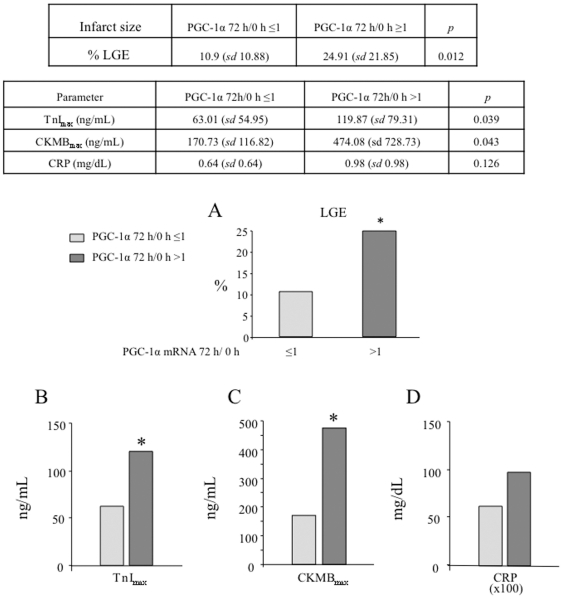
Patients that induce PGC-1α after STEMI have bigger necrotic areas.
A) Necrotic areas as estimated by late gadolinium enhancement (LGE). The infarct sizes, of the cohort of STEMI patients under survey, was determined by LGE on cardiac RMN (CMR). The estimated mean infarct size for patients that induced PGC-1α levels (PGC-1α 72 h/0 h ≥1) is compared to that of patients that did not induce PGC-1α (PGC-1α 72 h/0 h ≤1) after STEMI. B–D) PGC-1α induction positively correlates with cardiac necrosis as estimated by TnImax (B), CKMBmax (C), and CRP plasma levels (D). TnImax, CKMBmax, and CRP levels of the cohort of STEMI patients under survey The estimated mean for patients that induced PGC-1α levels (PGC-1α 72 h/0 h ≥1) is compared to that of patients that did not induce PGC-1α (PGC-1α 72 h/0 h ≤1) after STEMI. Data are means +/−SD. (*) p<0.05.